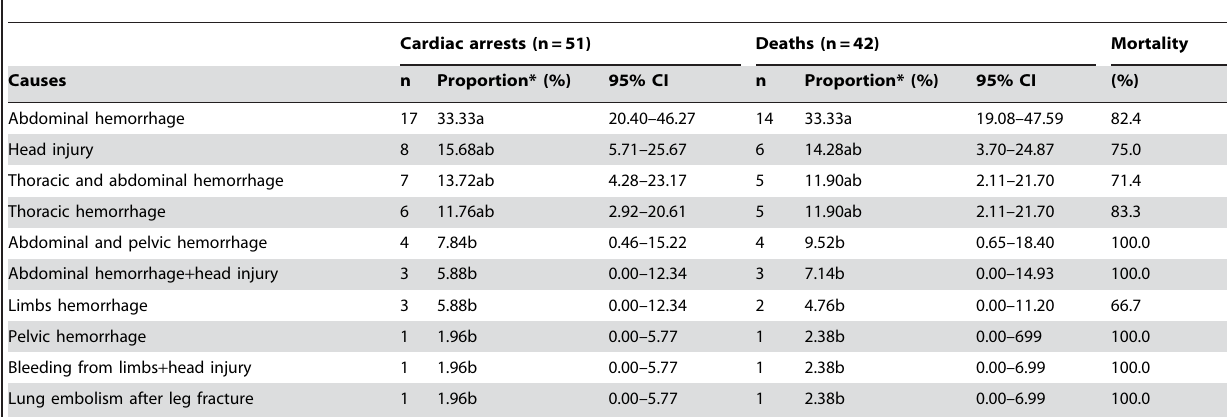
Table 5. Intraoperative cardiac arrest and death proportions in trauma patients, grouped by associated